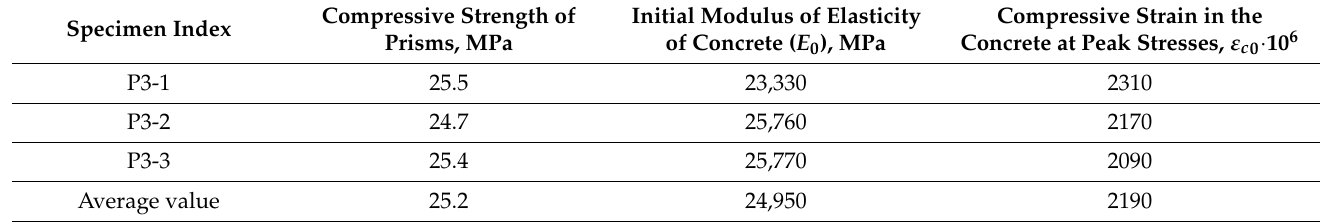
Table 4. Test results for concrete prisms.